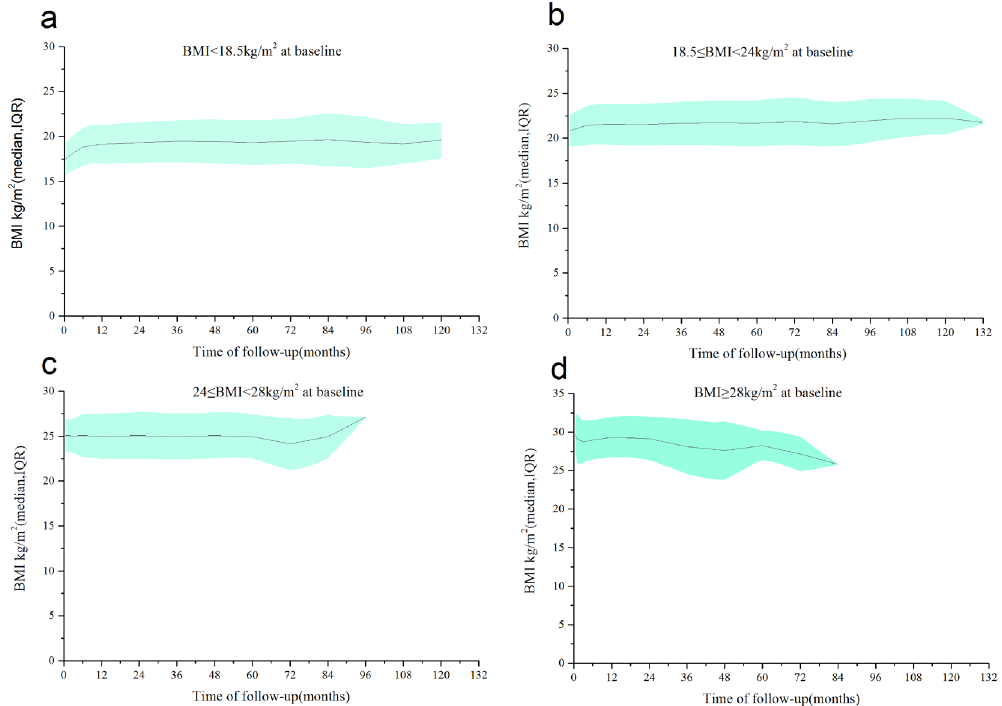
Figure 4. Mean BMI and standard deviation with respect to the time of follow-up in the four baseline BMI groups. ( a ) Average BMI with respect to follow-up time in the underweight group. ( b ) Average BMI with respect to follow-up time in the normal-weight group. ( c ) Average BMI with respect to follow-up time in the overweight group. ( d ) Average BMI with respect to follow-up time in the obese group.